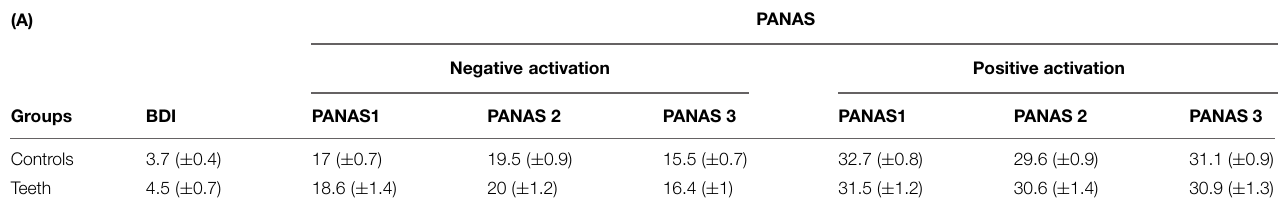
TABLE 1 | Mean scores of the Beck’s Depression Inventory (BDI), Positive and Negative Affect Schedule (PANAS) questionnaires, difficulty and unpleasantness assessment.